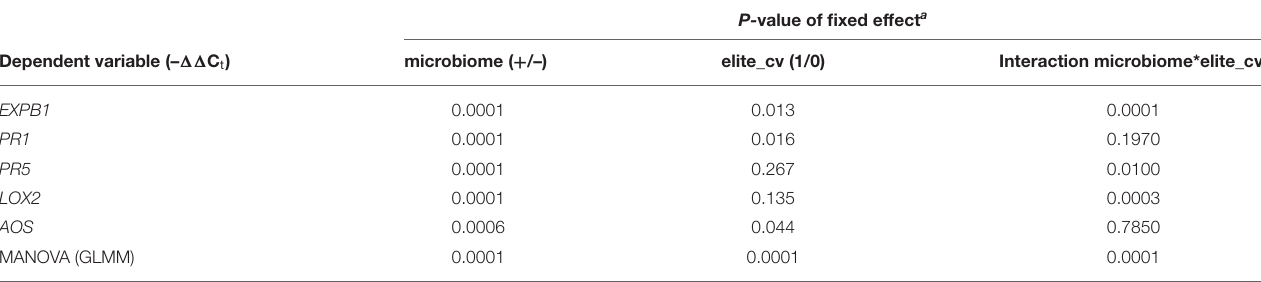
TABLE 3 | Generalized linear mixed models of microbiome-dependent defense gene expression of elite cultivars (Jolgeh and Yusuf) and ancestral genotypes (HS1 and HS2) of barley, 5 days after inoculation of RLN.